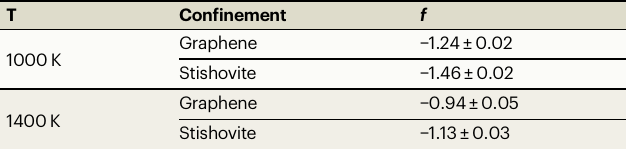
Table 1 | Acidity of aqueous carbon solutions: f = pH - pOH